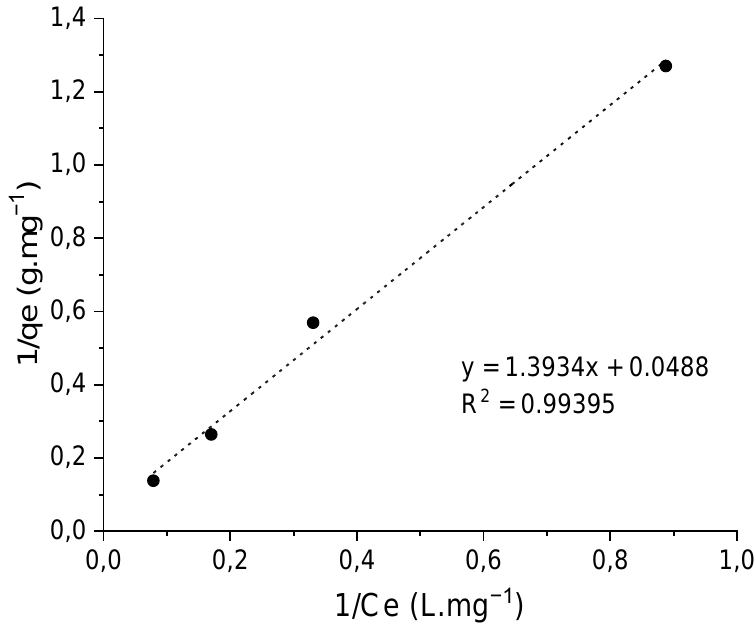
Figure 13. Langmuir isotherm (1/ q e vs. 1/ C e ) corresponding to OFL adsorption process, employing the PMMA x -co-PDEAEMA y /PVP-Fe x O y crosslinked fibrous membrane as an adsorbent at pH = 4 (R 2 = 0.994).